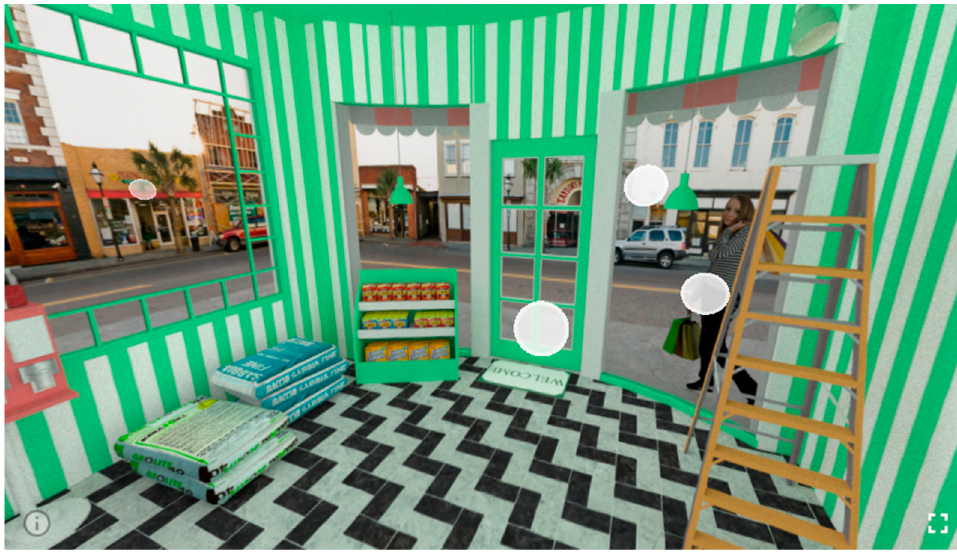
Figure 3. Scenario of business starting.